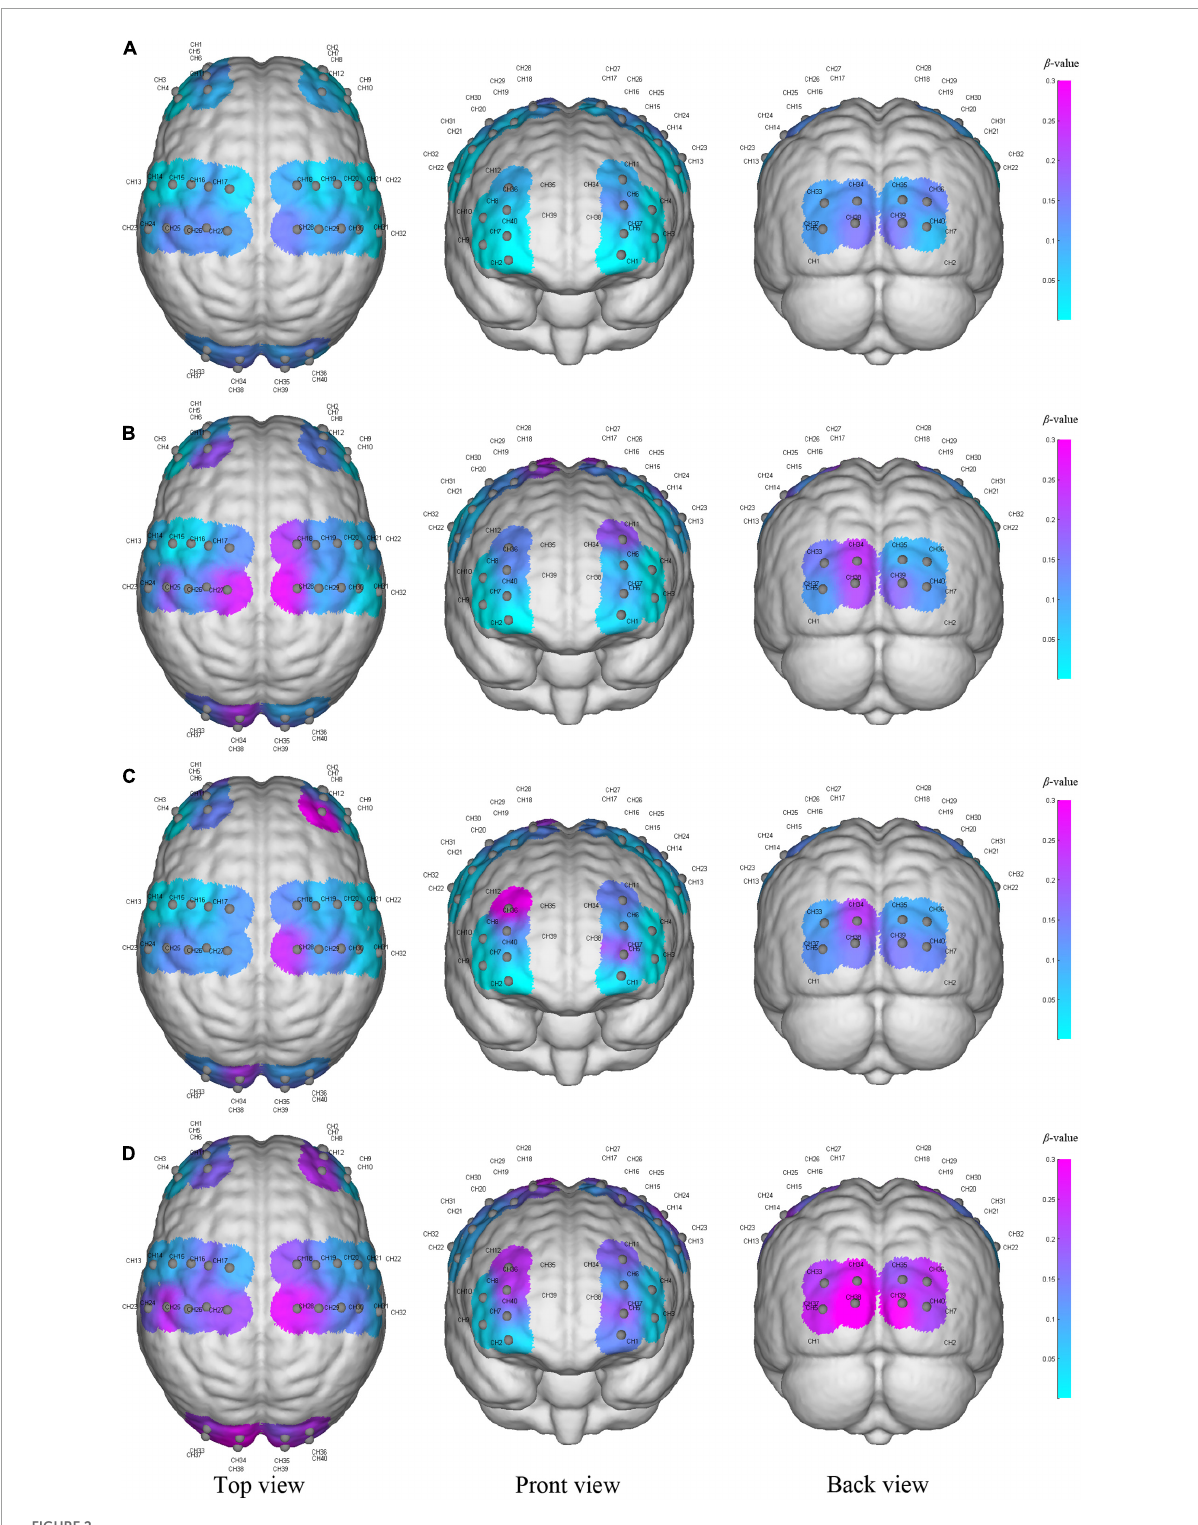
FIGURE2 The activation of the cerebral cortex during resting state (A) , initial stage (B) , intermediate stage (C) and sprint stage (D) under three viewing angles (top view, front view, and back view). The color reflects the mean β -value of each region on the time scale, and the purple color represents higher activation than the blue–colored regions. Gray node represents the channel formed by each light source probe and detector probe, and the CH number is the label of the